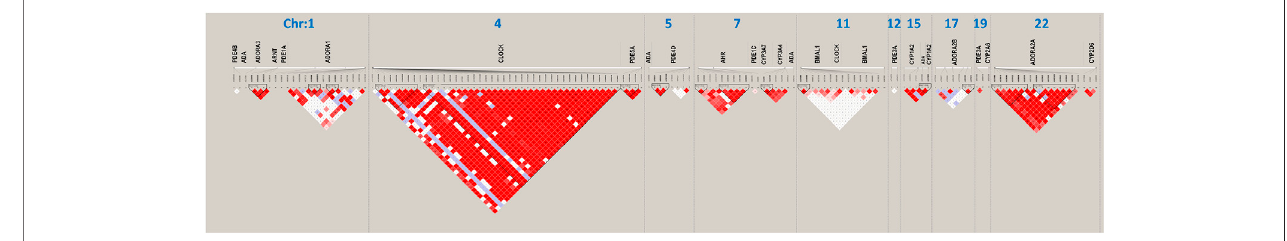
FIGURE 2 | Linkage disequilibrium (LD) structure (triangle plots) for all investigated single nucleotide polymorphisms (SNPs) (rs numbers below gene names). Red diamonds indicate strong historical LD, r 2 -based haplotype boundaries, among